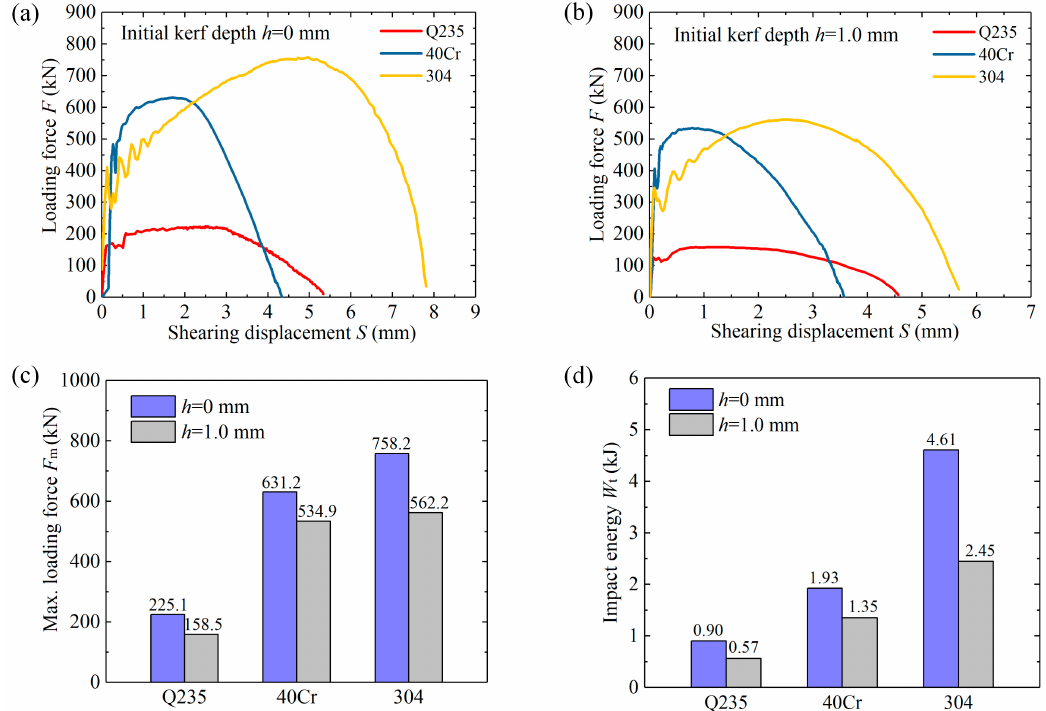
Figure 8. Loading force-displacement curves. ( a ) F - S curves for h of 0 mm. ( b ) F - S curves for h of 1.0 mm. ( c ) Max. loading force